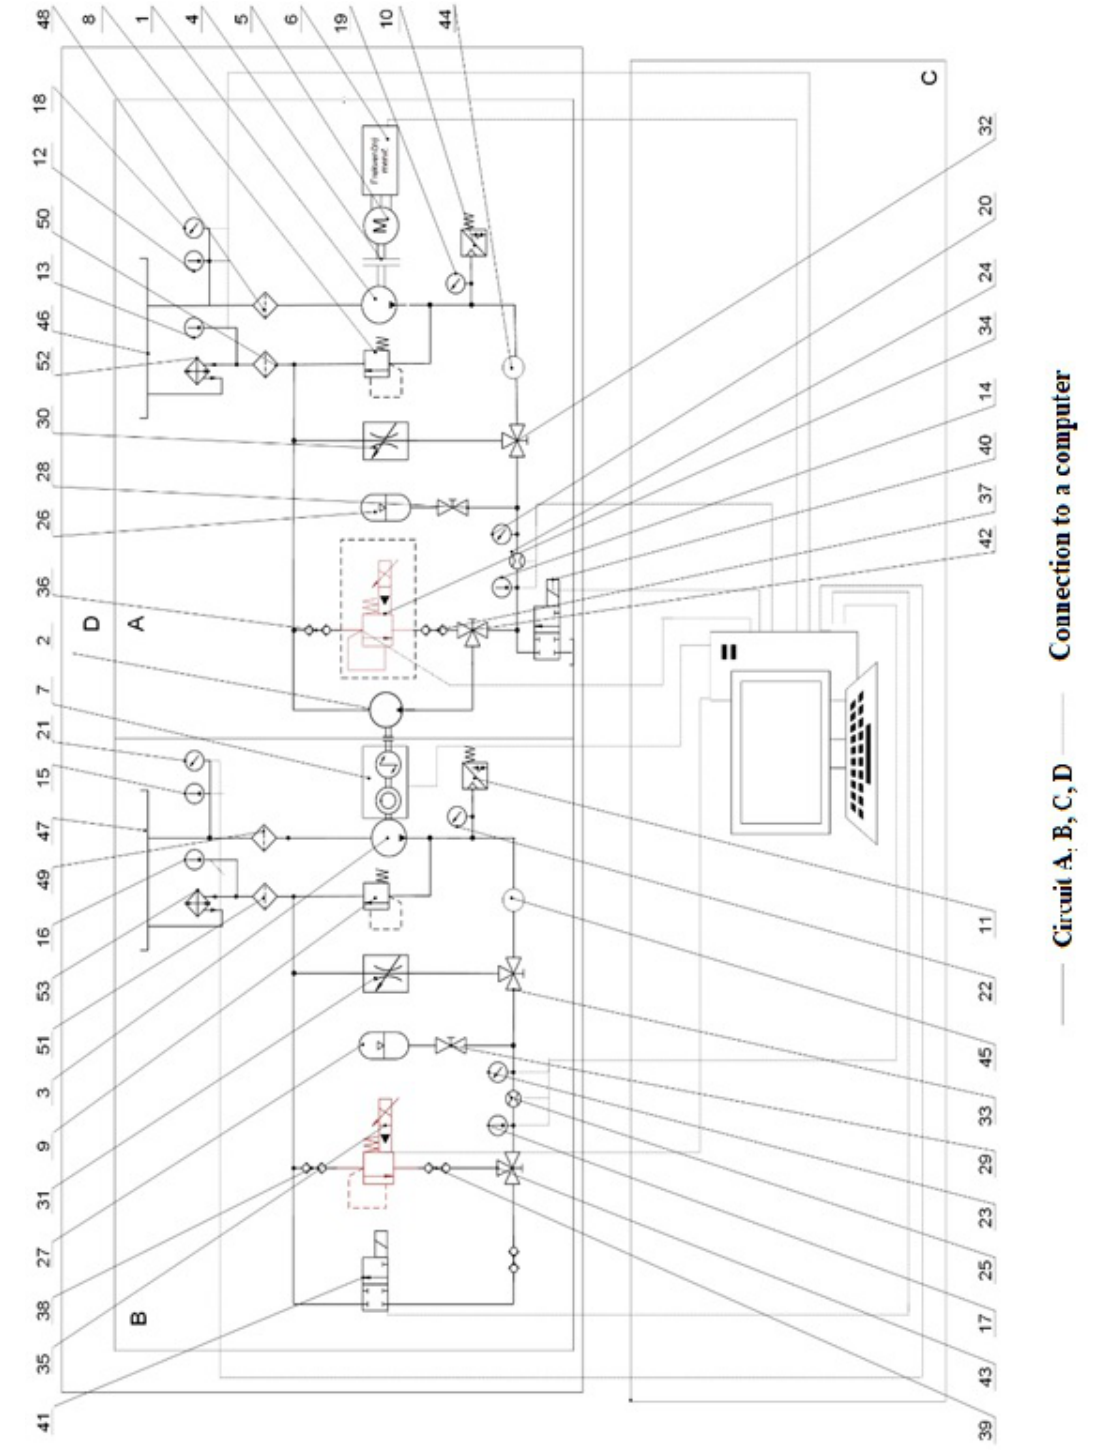
Figure 4 Figure 4. Schematic of the proposed laboratory test